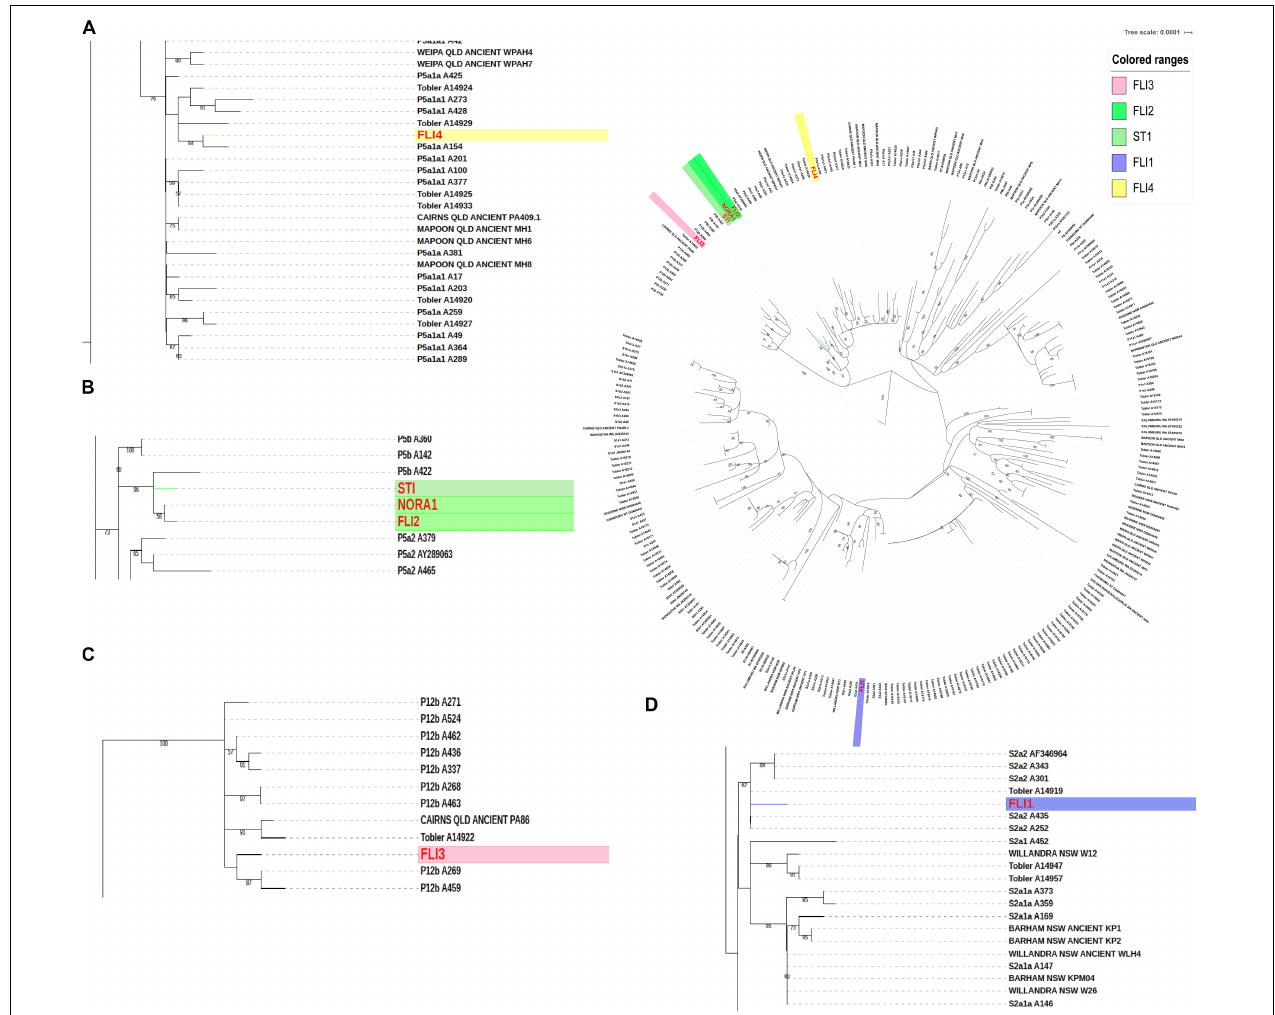
FIGURE 3 | Mitochondrial maximum likelihood phylogenetic tree. (A) FLI4 belongs to the P5a1a haplotype. (B) FLI2 and STI1 both belong to mitochondrial haplotype P5b1. (C) FLI3 belongs to the P12b haplotype. (D) The FLI1 showed a S2a